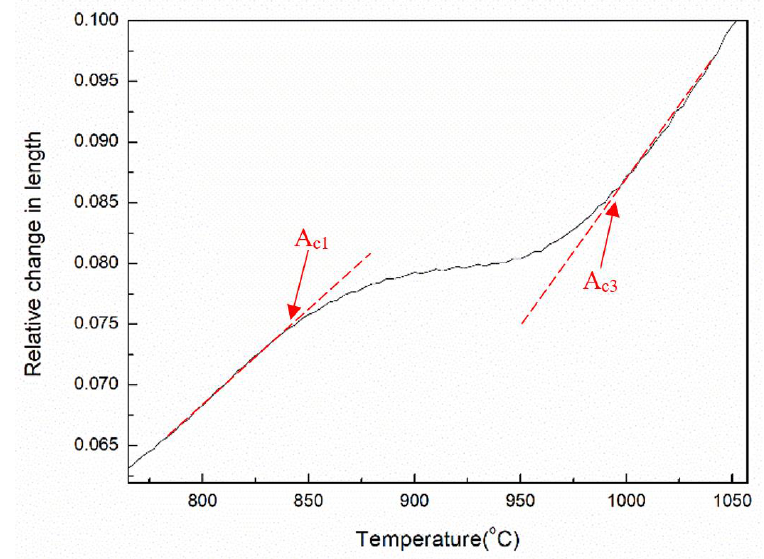
Figure 4. Thermal expansion curve of the low-carbon ferritic stainless steel sample during heating with a rate of 100 °C/min.